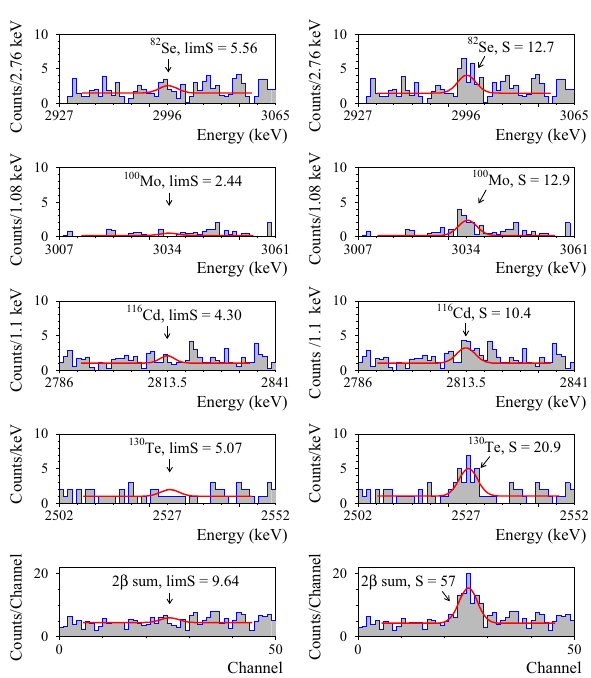
Fig. 3 Generated energy spectra for Zn 82 Se, Li 100 MoO 4 , 116 CdWO 4 2 and 130 TeO 2 detectors for the CUPID-4 option and sum energy spectra, assuming the background levels of Ref. [44]. The figures at the left column show the “no effect observed” case, while those at the right column illustrate effects for a neutrino mass of 0.05 eV calculated with the matrix elements from Ref. [46], the phase space factors from Ref. [47] and the value of the axial vector coupling constant g A = 1 . 27. Values of excluded lim S and peaks areas S are in counts